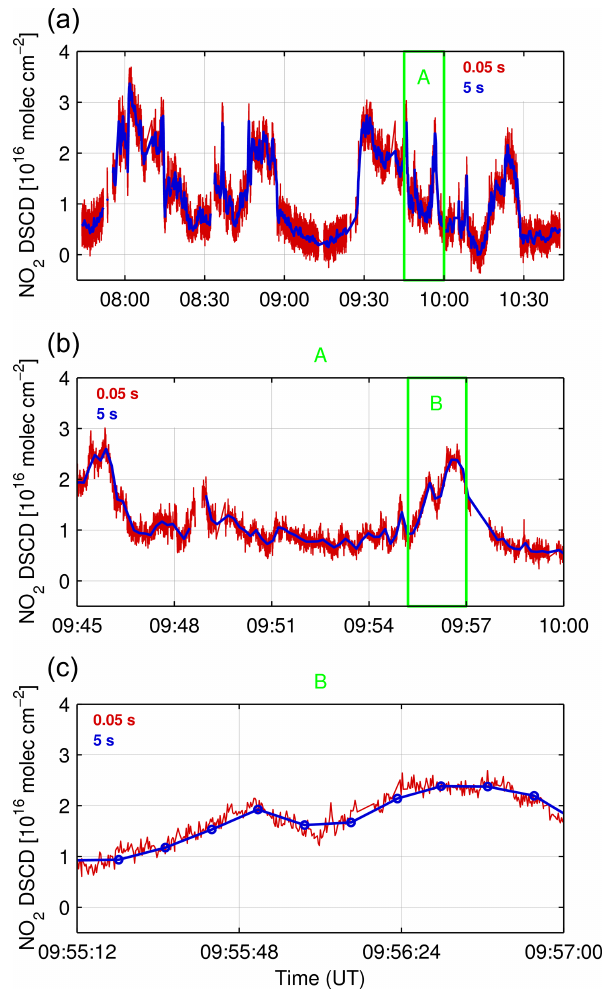
Figure 4. Temporal resolution of NO 2 DSCDs based on the car DOAS zenith-sky measurements performed on 3 November 2015. The red and blue lines show data at a resolution of 0.05 and 5s, respectively. Panel (a) shows the NO 2 DSCDs for the whole period of observations of that day, whereas (b) and (c) represent shorter time sections for clarity.